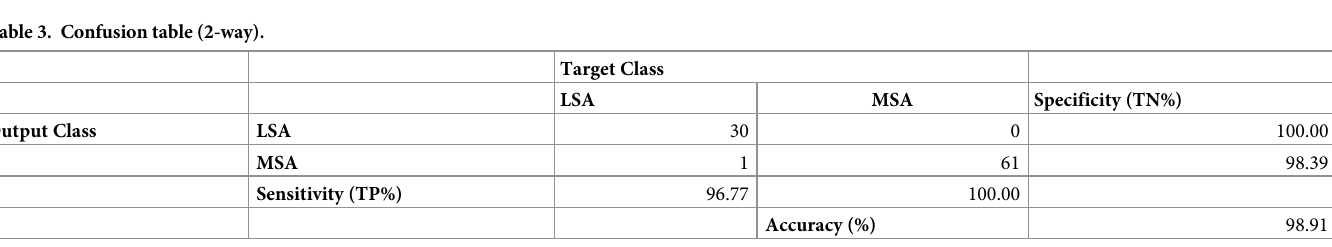
Table 3. Confusion table (2-way).